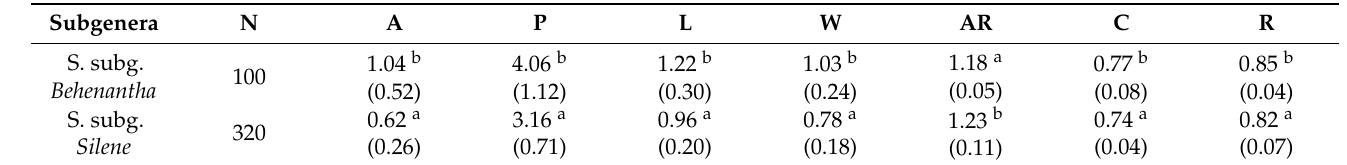
Table 3. Comparison of the mean values of the area (A), perimeter (P), length of the major axis (L), length of the minor axis (W), aspect ratio (AR), circularity (C), and roundness (R) in the lateral views of the Silene seeds between species in S. subg. Behenantha and S . subg. Silene . Between parentheses: standard deviation. Superscript letters indicate the results of T-Student analyses: the mean values marked with different letters in each column differ significantly at p < 0.05. N is the total number of seeds analyzed per subgenera.